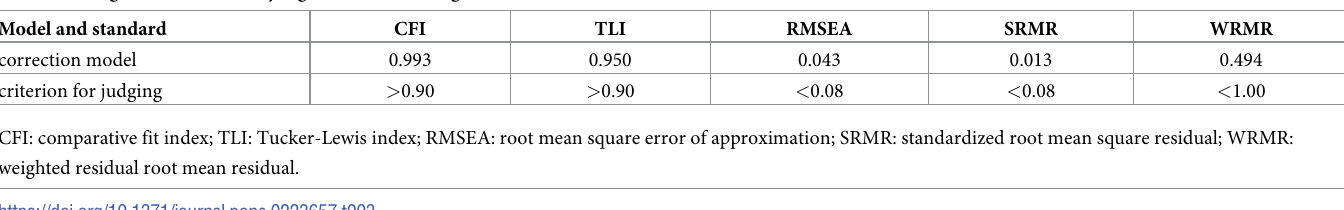
Table 3. The goodness of fit and judgment of mediating